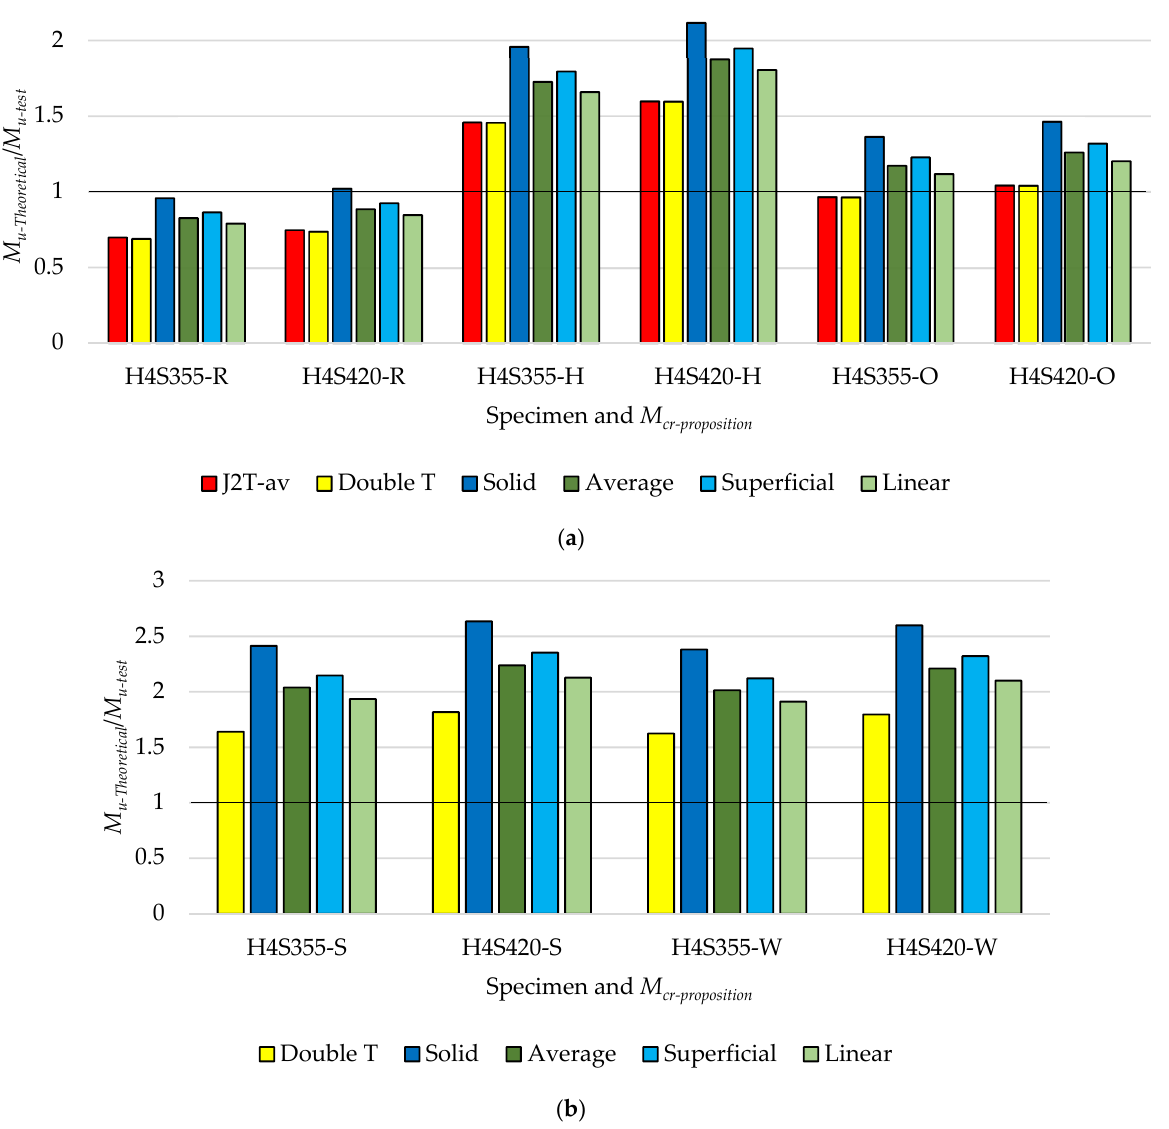
Figure 21. Accuracy obtained by the Salah’s M u proposition [58] for composite castellated beams: ( a ) M cr calculation based on the U-frame model; ( b ) M cr calculation proposed by Svensson [121] and Williams and Jemah [122].